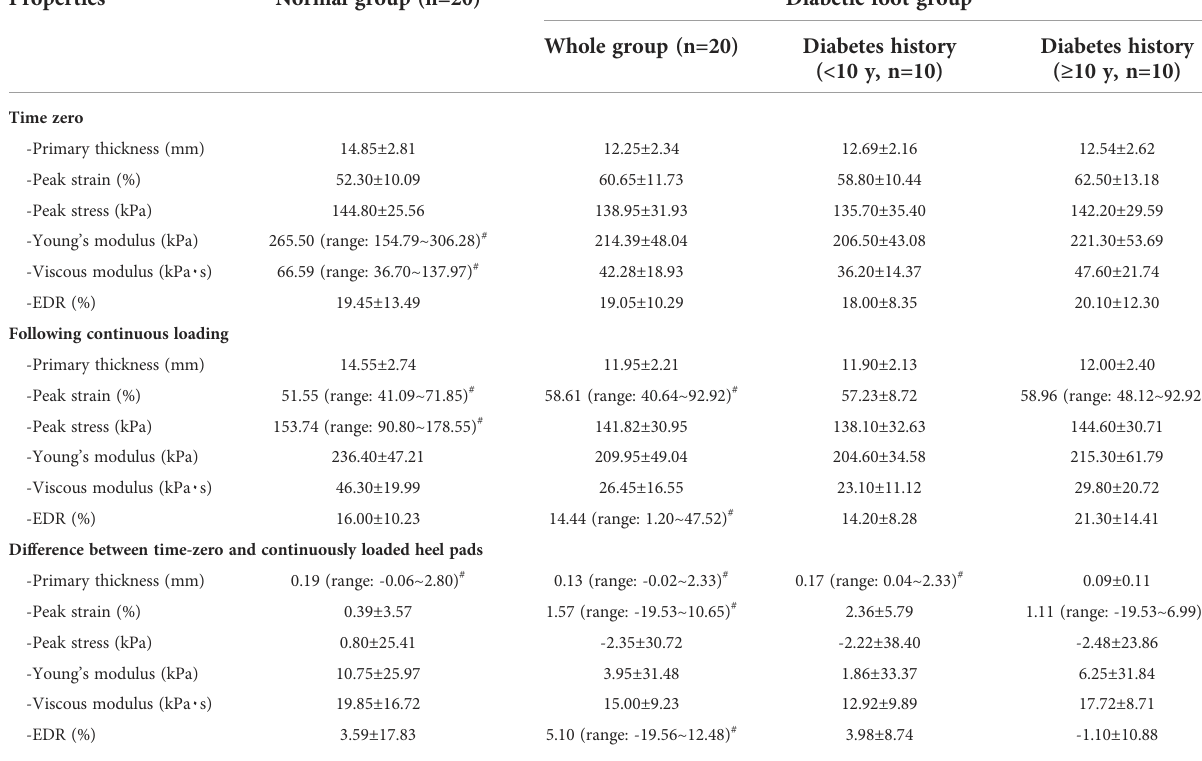
TABLE 2 Summaries of the material properties of plantar soft tissue at heels of normal adults and adults with diabetic foot. Properties